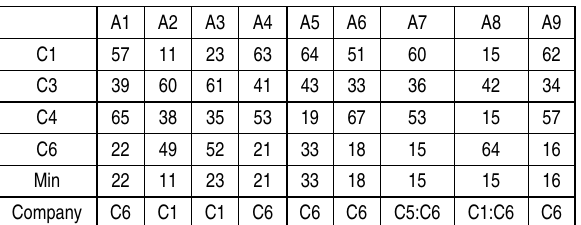
Table 27. MinMax